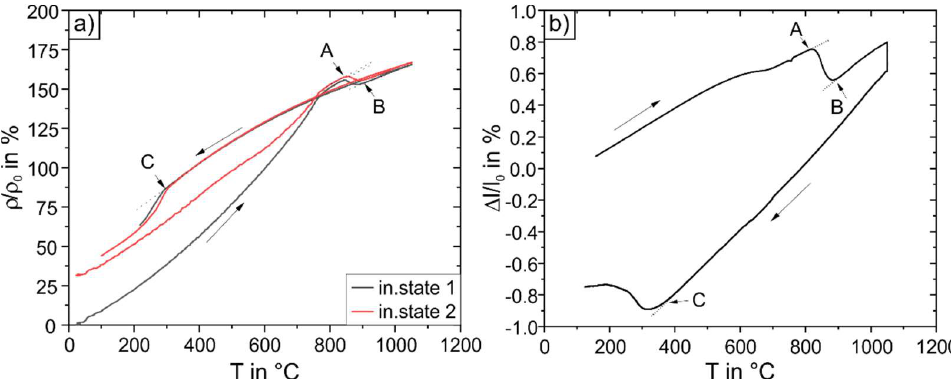
Figure 8. Results of the heat treatment NC150 ( a ) under hydrostatic pressure inside the HIP based on the ERM and ( b ) under ambient pressure using dilatometry. the ERM and ( b ) under ambient pressure using